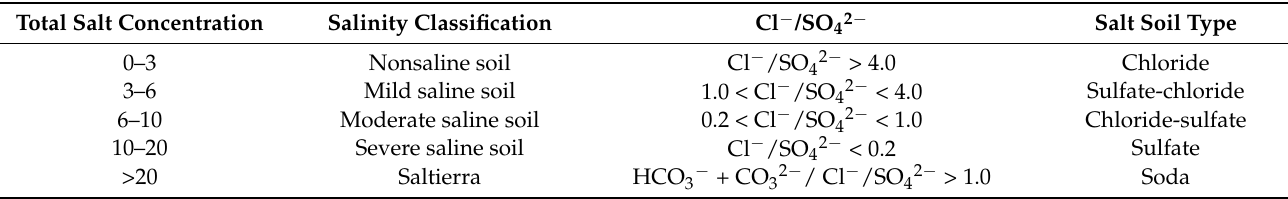
Table 1. Categorization standard of soil salinity and salt soil